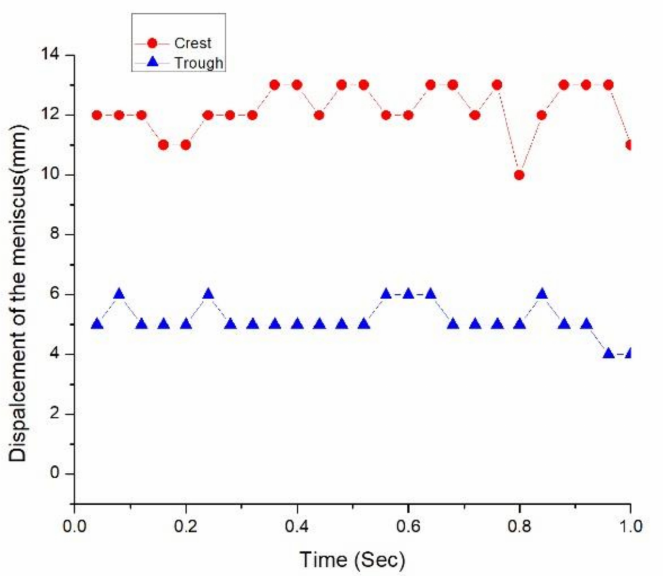
Figure 5. Displacement of the meniscus at crest and trough in one second for 15 ◦ downward rectangular port